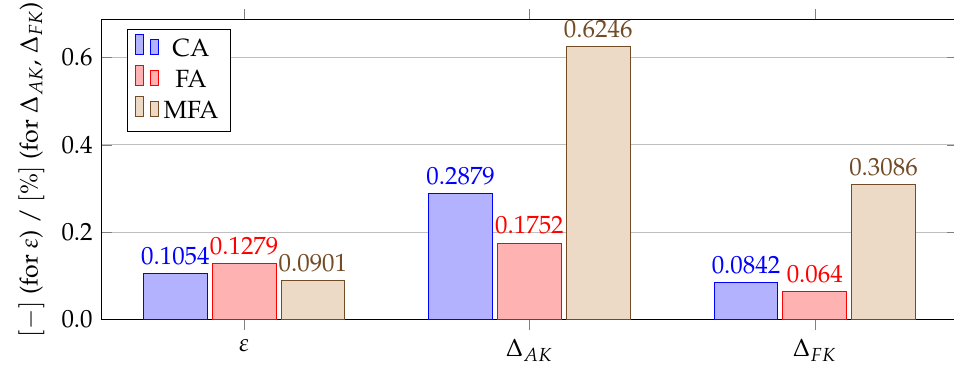
Figure 13. Comparison of shape parameters and error measures obtained using different algorithms for finding a good value of the shape parameter for test case 2, ∆ AF = 0.1469%.